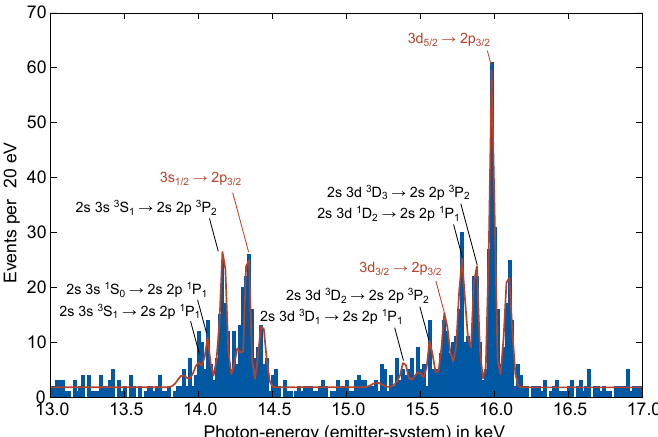
Figure 2. The spectrum contains X-ray transitions from the M- to the L-shell, resulting from the impact excitation of U 89 + (red text) as well as the electron capture into excited states of U 88 + (black text). For simplicity, the 1s 2 term has been omitted from all given electronic configurations of U 88 + ions. Overlaid is a fit to a model containing all identified lines (red